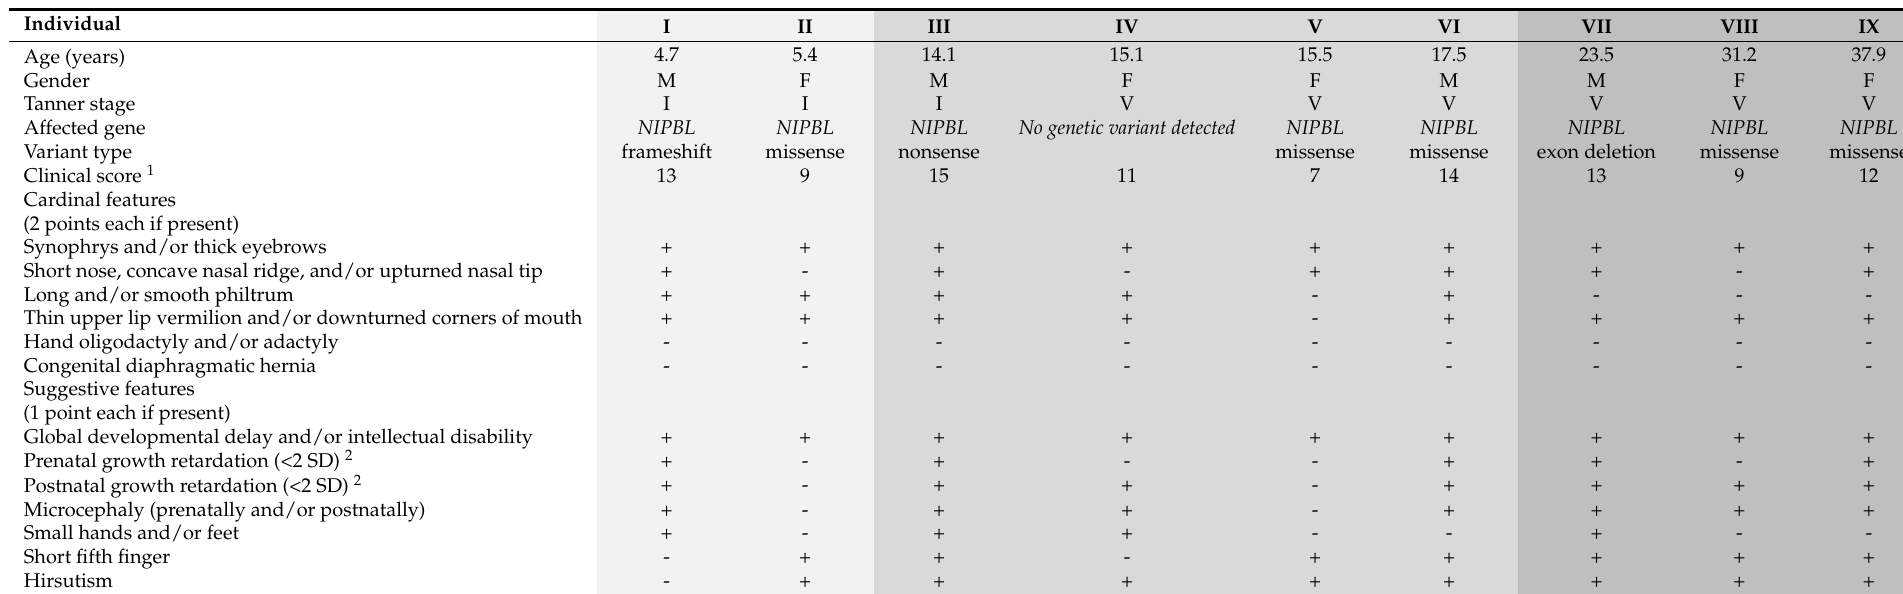
Table 1. Demographic, anthropometric, and clinical characteristics, affected genes, and clinical scores of individuals with Cornelia de Lange